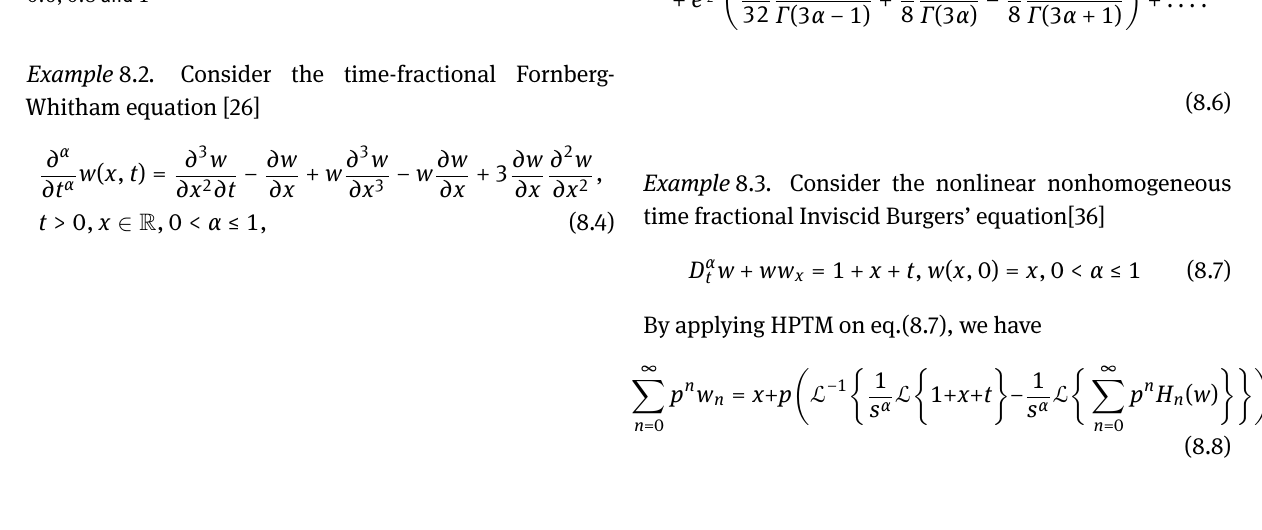
Fig. 5: Plot of of w ( x , t ) of eq. (8.1) when x = 0.4 and α = 0.6, 0.8 and 1